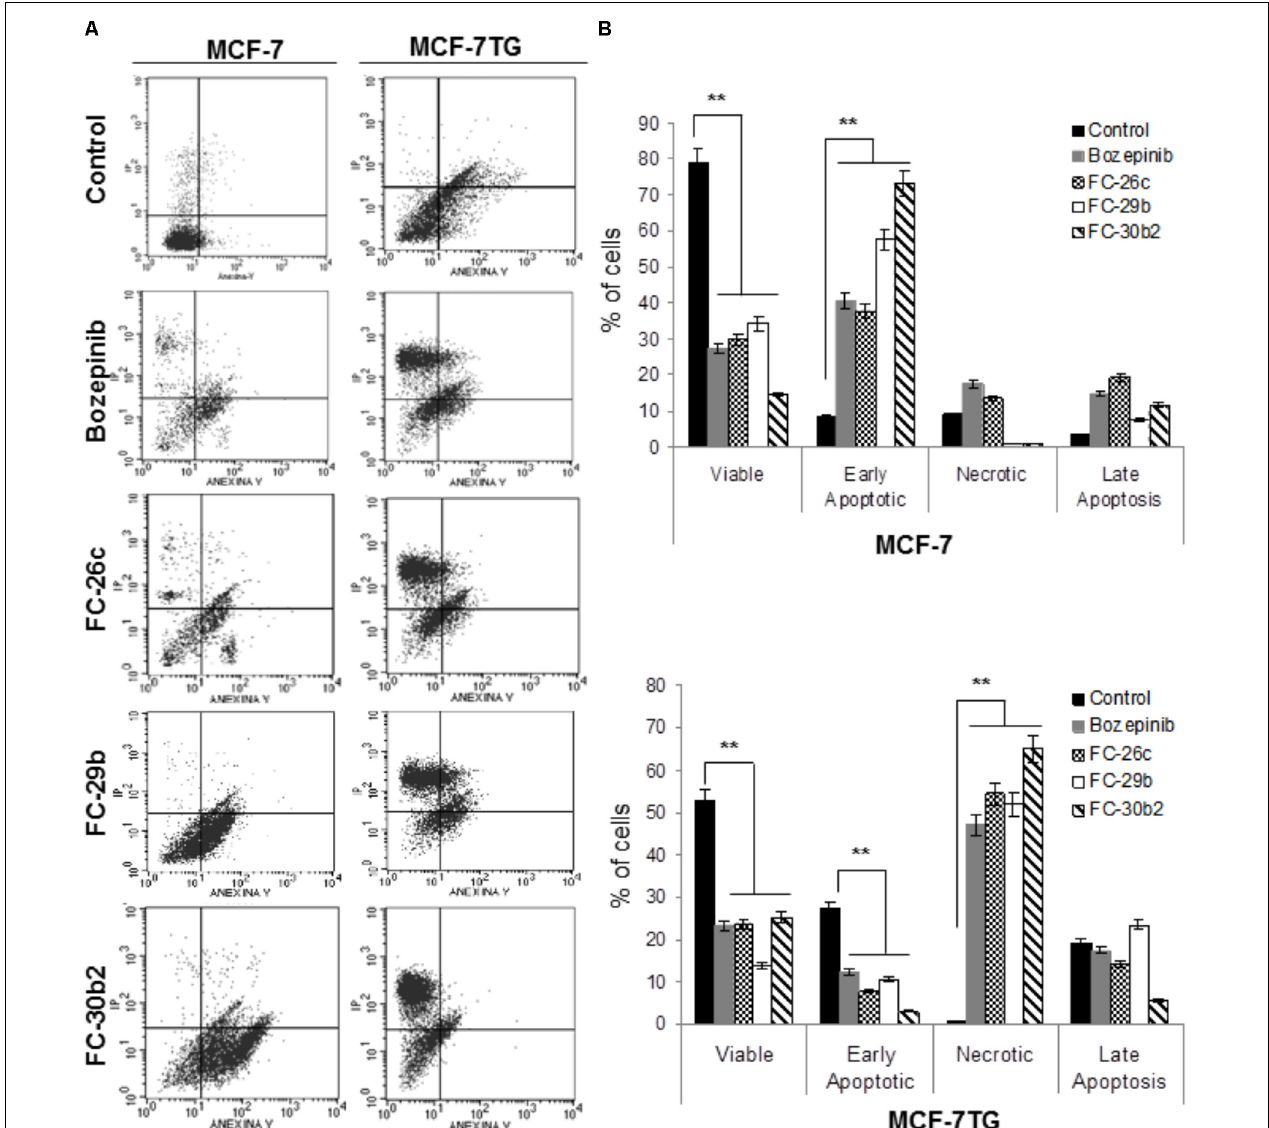
FIGURE 4 | Cell death is enhanced by combination of gef gene and drugs. MCF-7 and MCF-7TG cell lines were mock-treated (control) or treated with IC 50 of the most antiproliferative compounds for 72 h. Treated cells were then trypsinized and analyzed by flow cytometry using an annexin V-fluorescein isothiocyanate detection kit. (A) Representative images from flow cytometry analysis. (B) Data are expressed as the mean ± standard error of the mean of three independent experiments. ∗∗ P < 0.01 ( t